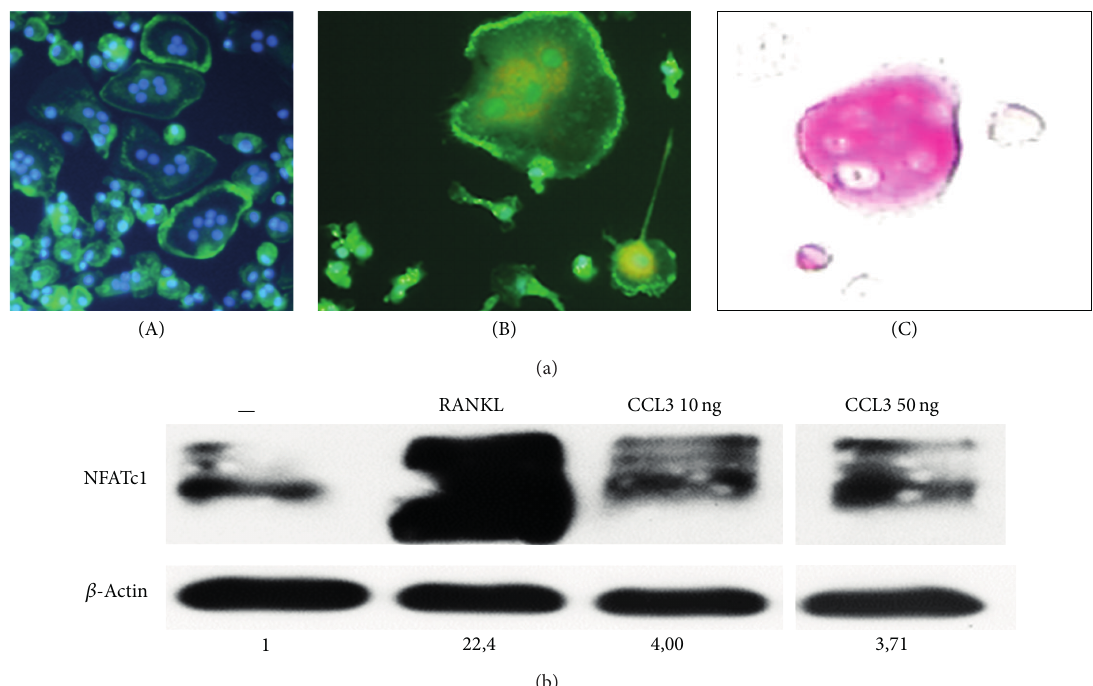
Figure 4: Generation of osteoclasts by CCL3. (a) Monocytes were cultivated with CCL3 (10ng/mL); at day 18, giant cells with multiple nuclei (blue) and 𝛽 actin in a ring-like structure were seen (A). These cells also expressed cathepsin K (B red) and TRAP (C). (b) Stimulation with CCL3 induced the induction of NFATc1. A Western blot of cell lysates derived from untreated cells (-) or from cells incubated with RANKL or CCL3 is shown. The loading of the gel was controlled and normalised using 𝛽 actin; the numbers indicate the increase over untreated cells (for technical reasons, sample CCL3 50 ng had run in a distant lane and was cut and